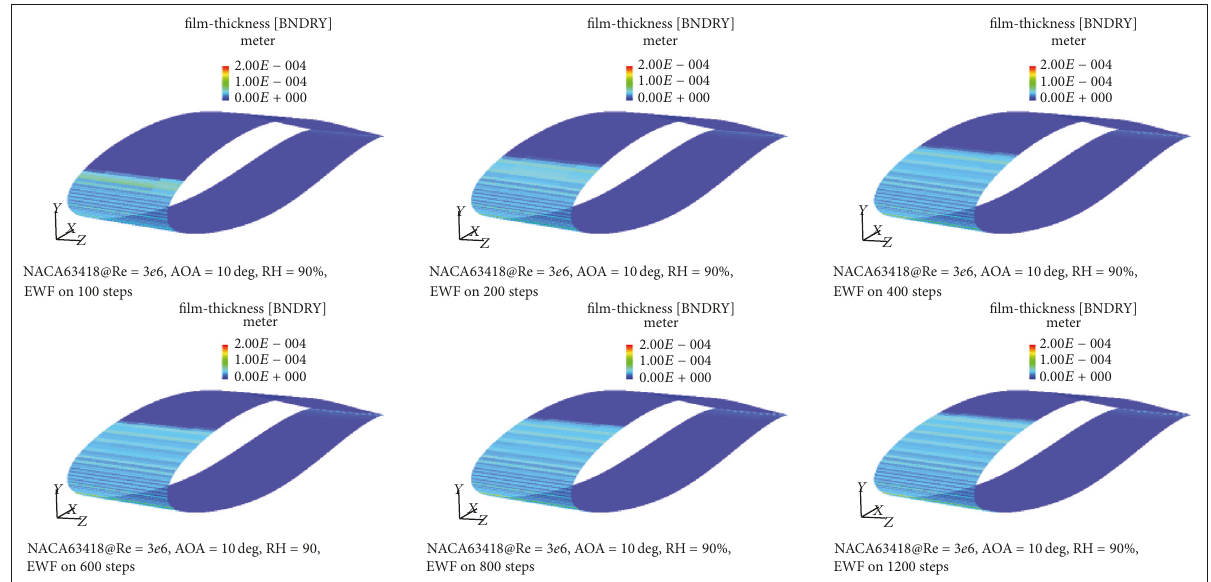
Figure 12: Contour plots of water film thickness with times (steps) on airfoil for AOA = 10 degrees (EWF model).